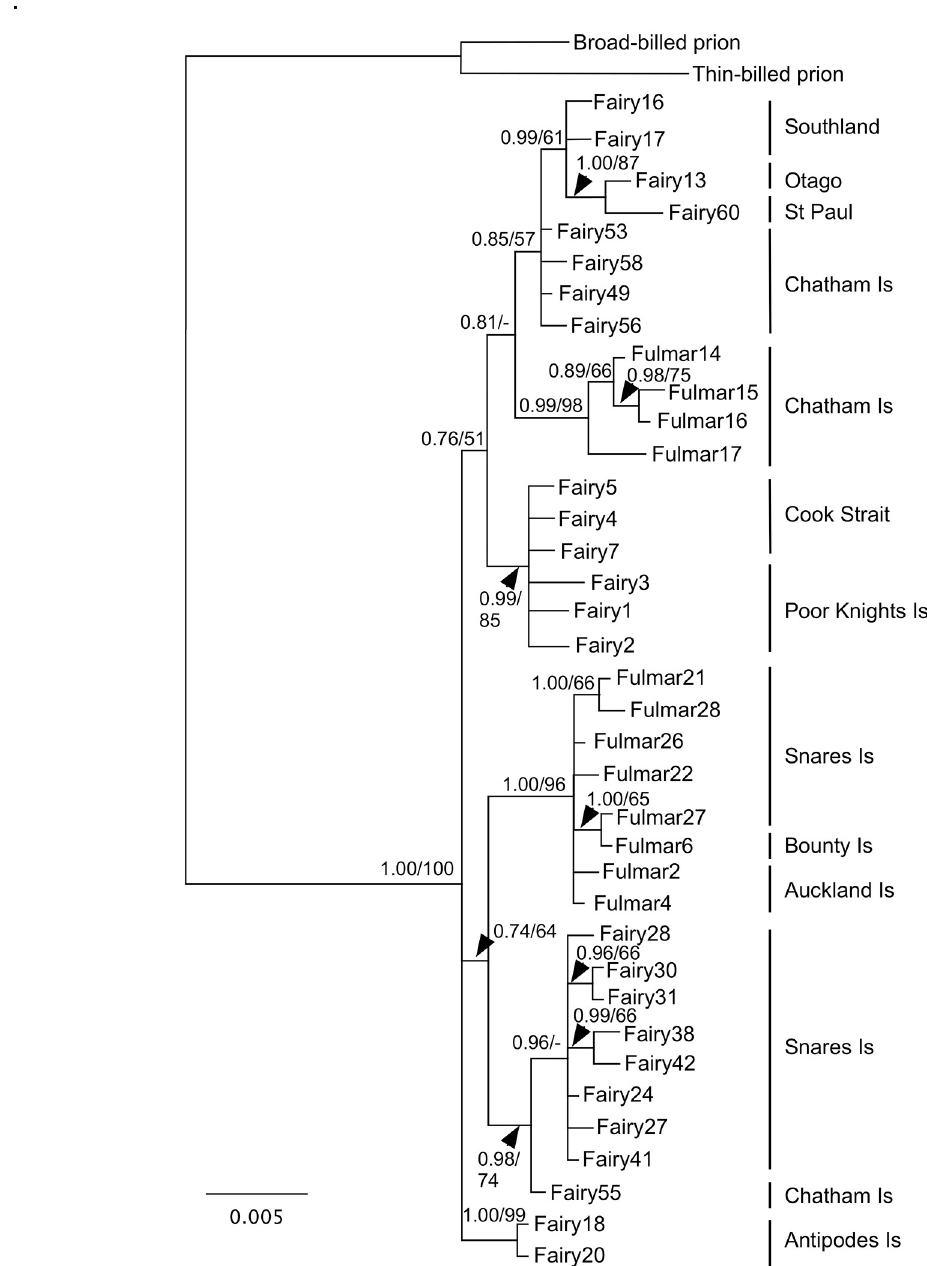
Fig 4. Bayesian phylogeny of concatenated COI and cytochrome b sequences for fairy and fulmar prions. Support values for nodes are as follows: Bayesian posterior probability/maximum likelihood bootstrap. https://doi.org/10.1371/journal.pone.0275102.g004 The 10 pairwise D statistics calculated between Snares Islands fairy prions, Snares Islands fulmar prions, Chatham Islands fairy prions, Chatham Islands fulmar prions and Auckland Islands fulmar prions ranged from 0.002 to 0.018. None was significant (p > 0.2), indicating that there is no signal of hybridisation. Furthermore, no hybridisation events were inferred from the HyDe analyses.